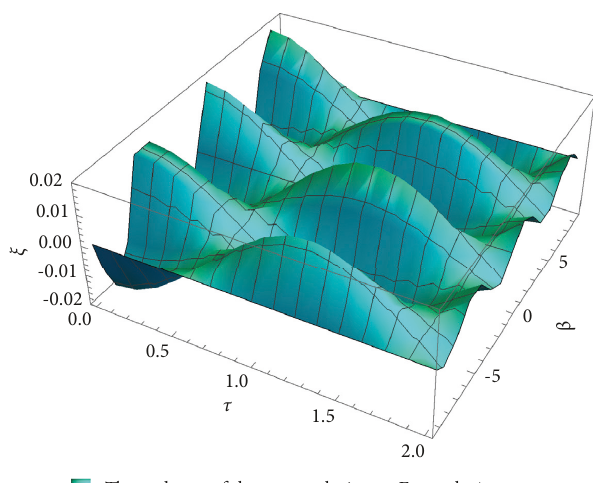
Figure 23: The real part of the exact solution to Example 4.